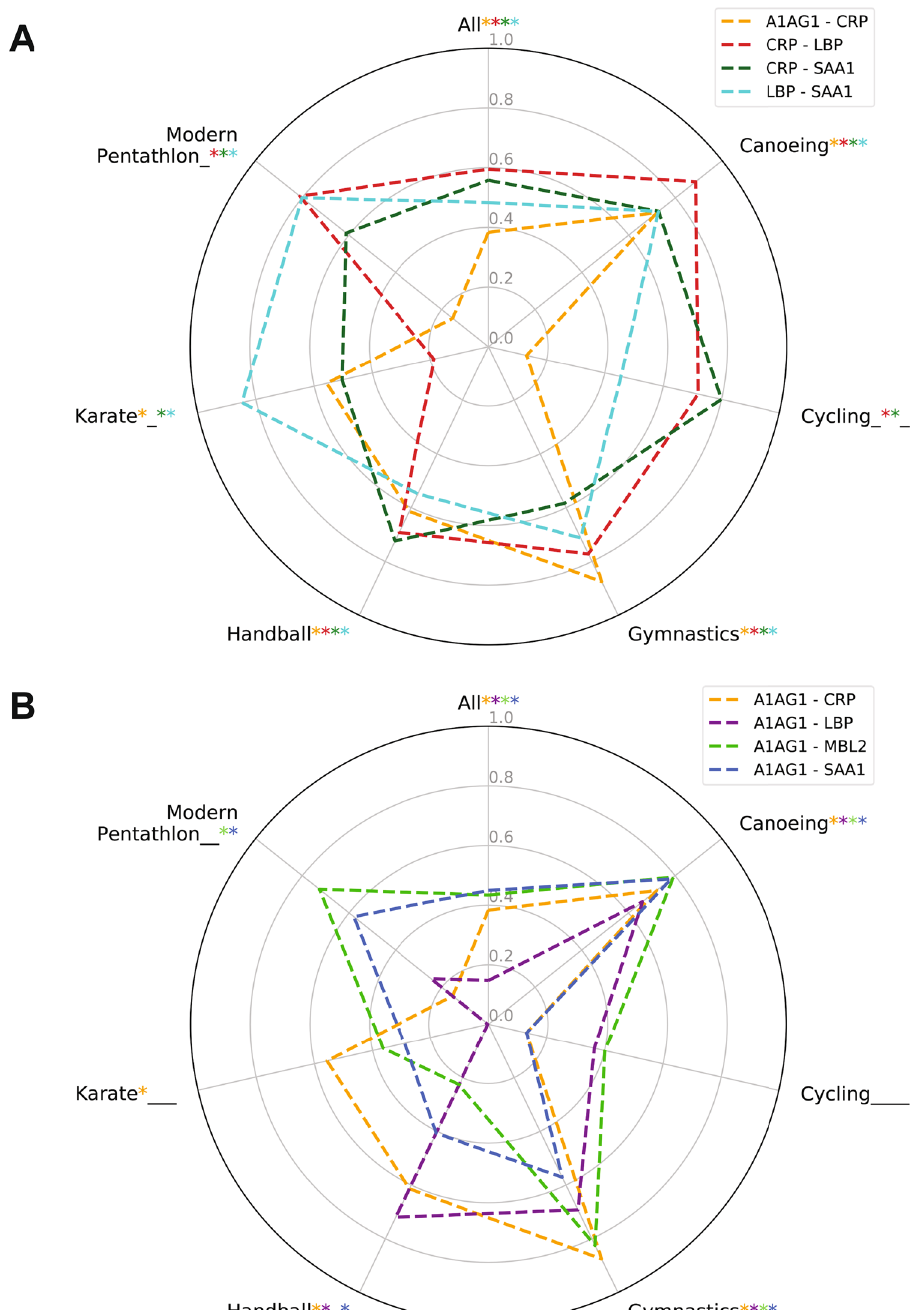
Figure 5. Seven proteins correlated in three or more sports. Matrix of pairwise correlations (r s ) among proteins for canoeing; cycling; gymnastics; handball; karate, and modern pentathlon. The significant correlations at p value < 0.001 are shown (*). Full data are presented in Supplementary Material 1. Alpha-1-acid glycoprotein— A1AG1; Albumin—ALBU; Cystatin C—CYTC; C-reactive protein CRP; Hemoglobin beta chain—HBA; Haptoglobin—HPT; Insulin-like growth factor 1—IGF1; Lipopolysaccharide binding protein—LBP; Mannose- binding lectin—MBL2; Myeloperoxidase—PERM and Serum amyloid